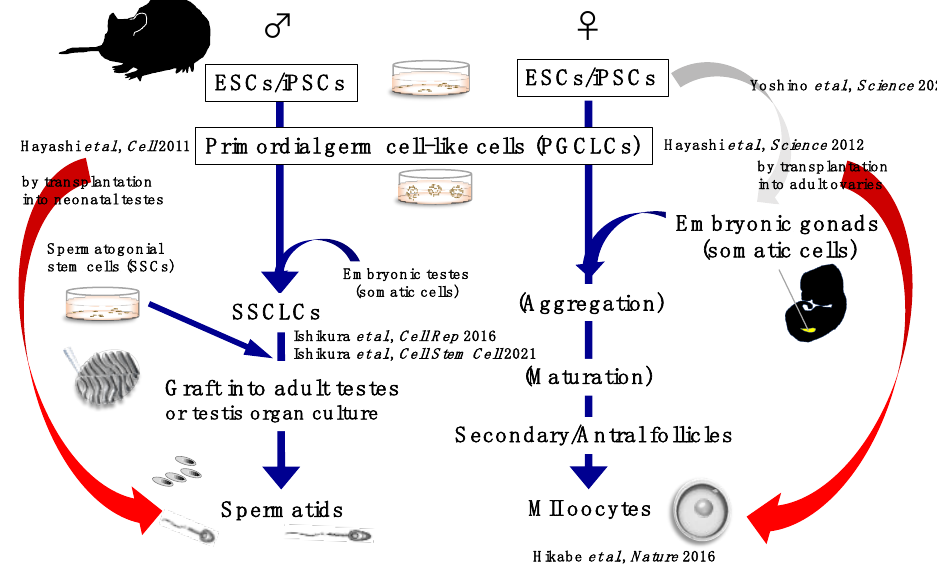
Figure 1. A graphical schematic of in vitro gametogenesis from murine PSCs.